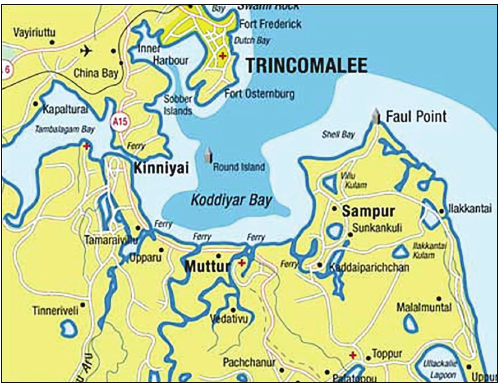
Figure 2: Map of Trincomalee